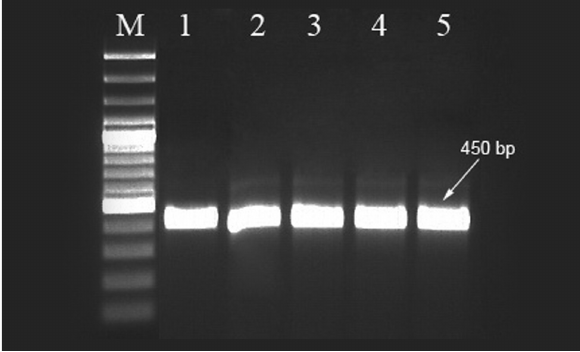
Agarose gel electrophoresis of PCR products for identification of Phytophthora cinnamomi using LPV3 species-specific primers.